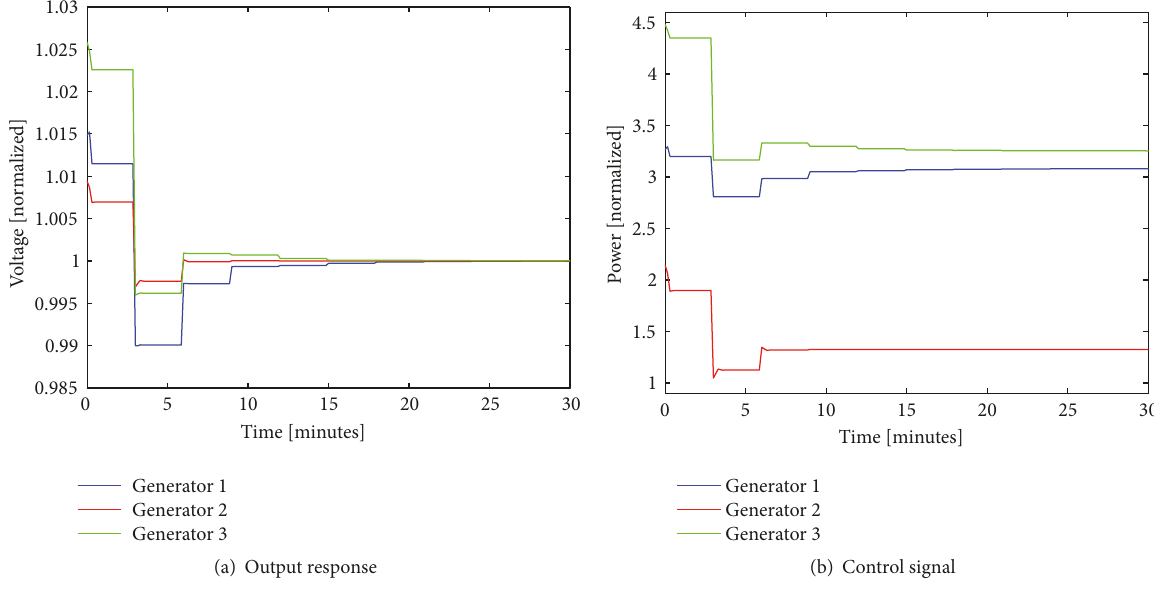
Figure 23: Detail of the adaptive control system